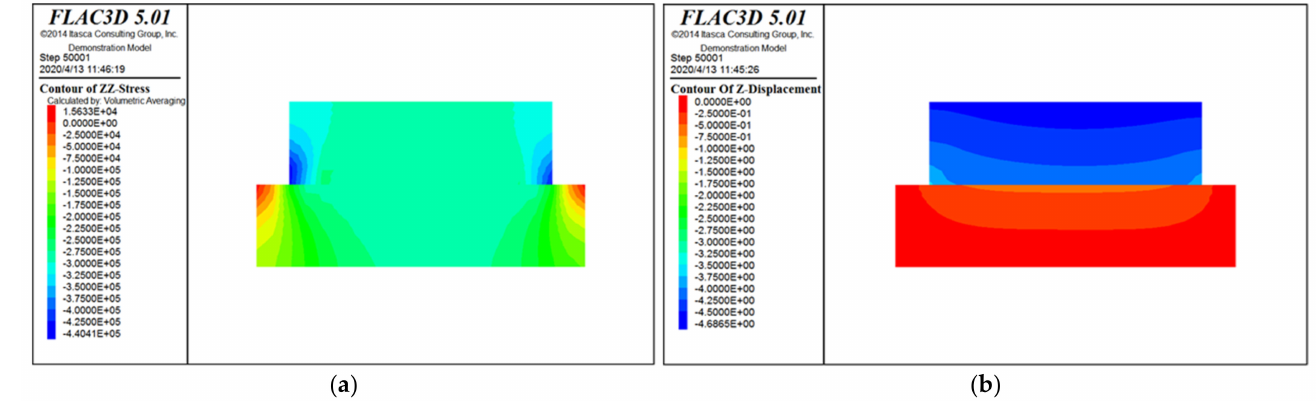
Figure 11. Z -direction stress and displacement cloud diagram. ( a ) Stress cloud diagram; and ( b ) displacement cloud diagram.